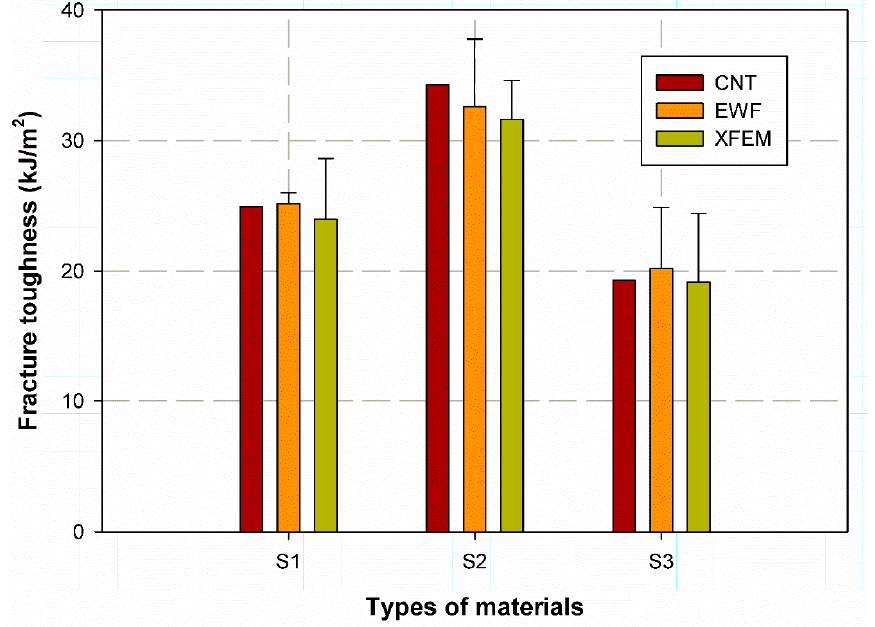
Figure 15. Comparison of EWF with other methods.